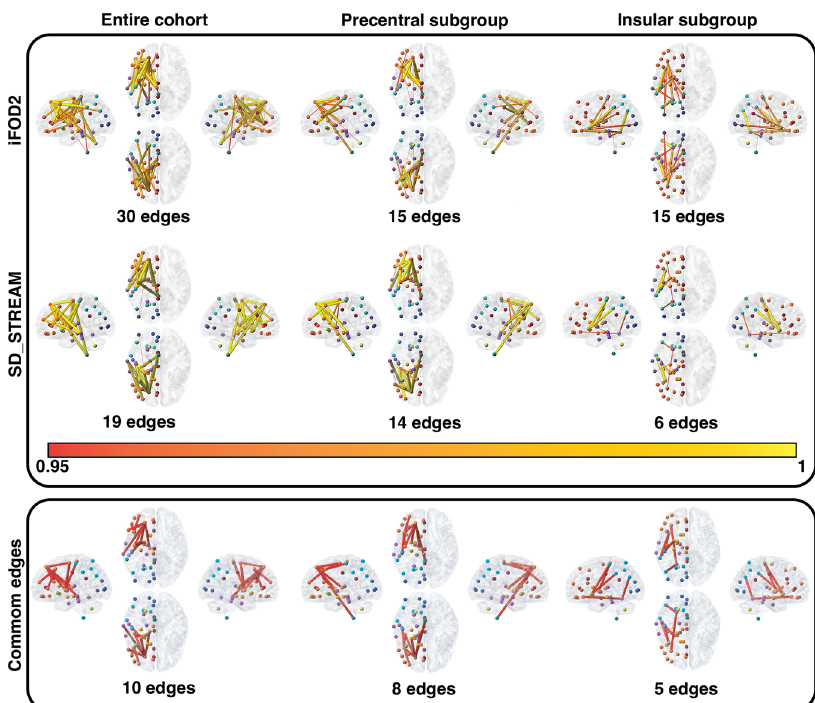
Fig. 2 TFNBS results visualizing the signi fi cant differences between ipsi- and contralesional connectome matrices. The heatmap indicates the FWE- corrected signi fi cance (1-p, only signi fi cant edges are displayed with p -values < 0.05). The node colors re fl ect the atlas parcellation (Desikan – Killiany – Tourville) color scheme. Common edges: Signi fi cant edges that were signi fi cant in both tractography (iFOD2 & SD_STREAM) algorithms ( p -values < 0.05), cf. Supplementary Information